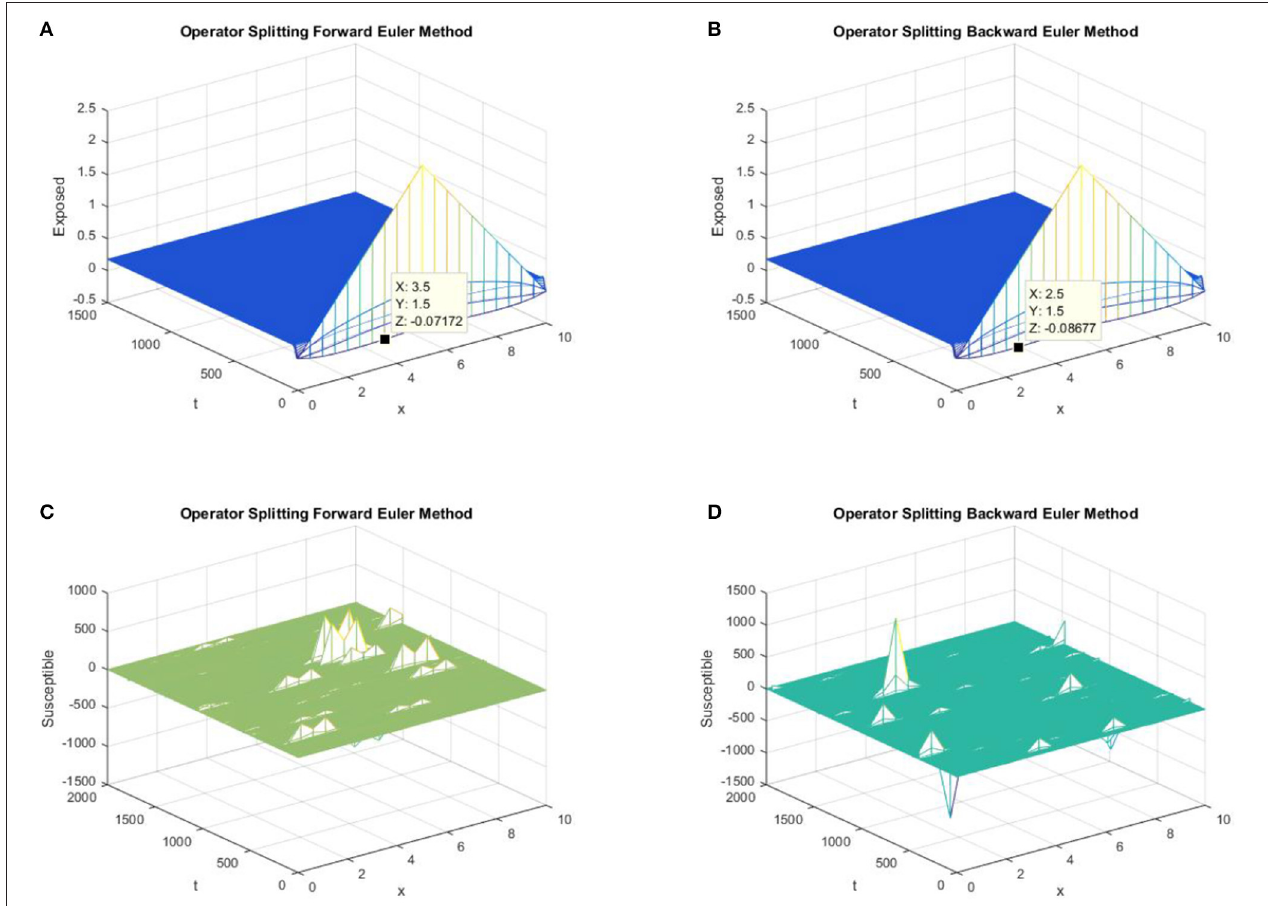
FIGURE 7 | (A) The forward Euler FD operator splitting method is used to simulate the graph of exposed persons for the DFE point at h = 0.5, λ 1 = 0.3. (B) The backward Euler FD operator splitting method is used to simulate the graph of exposed persons for the DFE point at h = 0.5, λ 1 = 0.3. (C) The forward Euler FD operator splitting method is used to simulate the graph of susceptible persons for the DFE point at h = 0.5, λ 1 = 0.4. (D) The backward Euler FD operator splitting method is used to simulate the graph of susceptible persons for the DFE point at h = 0.5, λ 1 = 0.4.